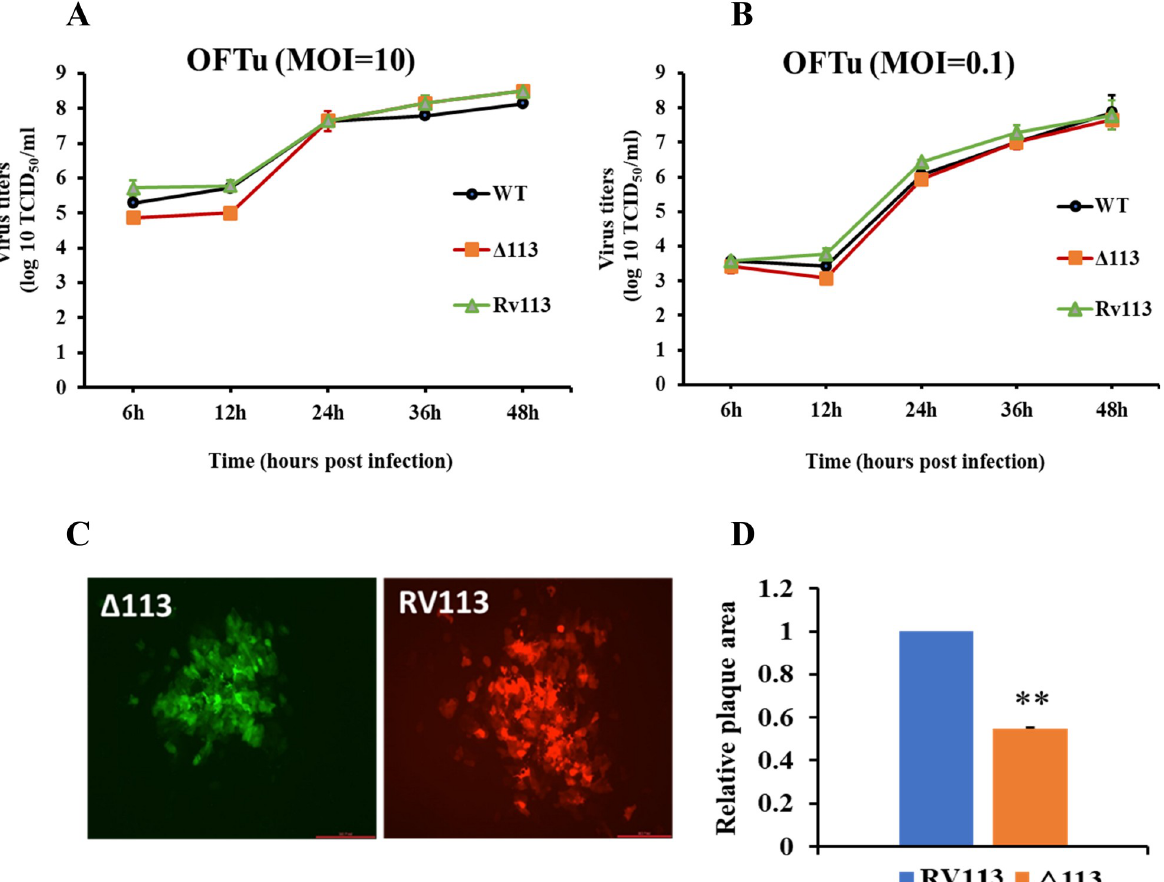
Fig 2. Replication characteristics of ORFV113-gene deletion virus. (A and B) OFTu cells were infected with wildtype OV-IA82 (WT), ORFV113 deletion mutant OV-IA82 Δ 113 ( Δ 113) or revertant OV-IA82RV113 Flag (RV113) viruses. (A) Single-step growth curve, MOI 10; (B) Multi-step growth curve, MOI 0.1. Titers were determined at indicated times p.i. and expressed as TCID 50 /ml. Results are average of two independent experiments. (C and D) Plaque morphology of ORFV113-gene deletion virus. OFTu cells were infected with OV-IA82 Δ 113 ( Δ 113) (GFP reporter) or OV-IA82RV113 Flag (RFP reporter) viruses and plaque assay was performed. Shown are representative fluorescent plaque images taken at 5 d p.i. (D) Random plaques were imaged (n = ~100), and plaque area was measured using Nikon A1 software. Relative Δ 113 plaque areas compared to RV113 plaques are shown. Results are the average of three independent experiments. Error bars represent mean ± SD. Statistical analysis was performed using paired Student’s t-test ( �� , P < 0 . 01